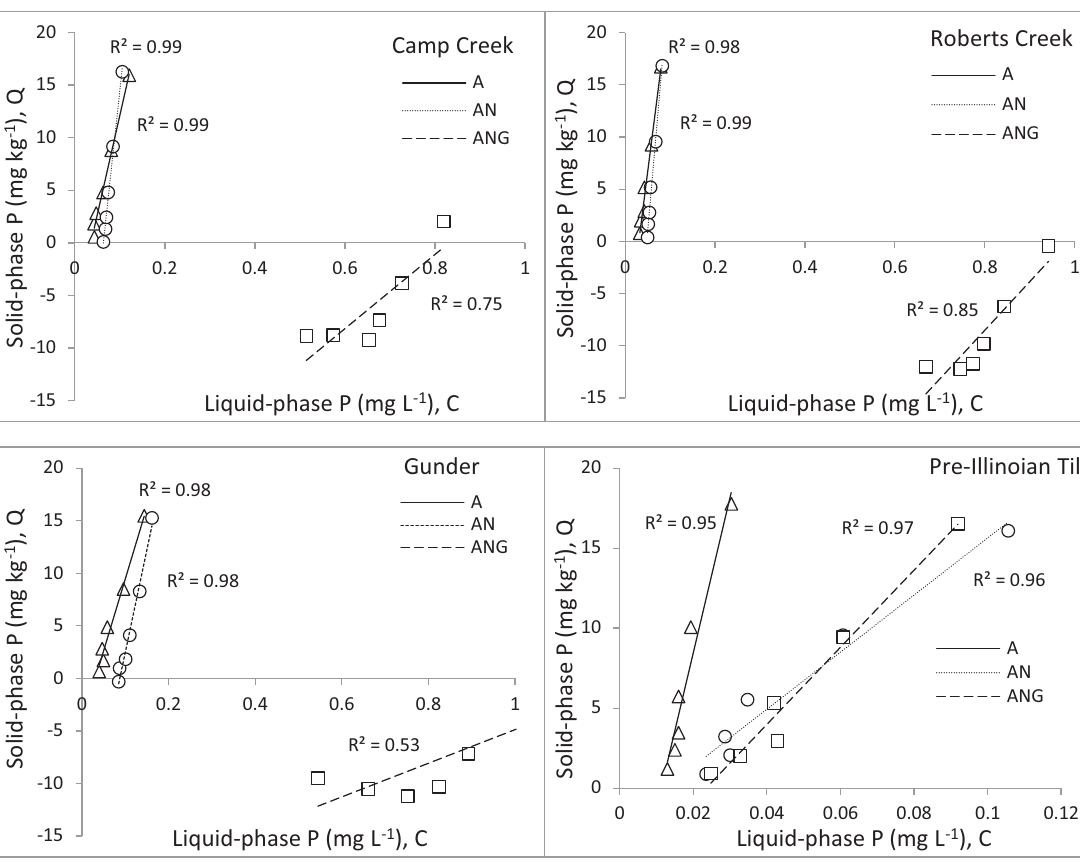
Fig 5. Phosphorus adsorption isotherms developed with simple linear regression for four sediments subjected to three experimental treatments (A = without anaerobic incubation ( Δ ), AN = with anaerobic incubation ( � ), and ANG = with anaerobic incubation + glucose ( □ )). Each of the C and Q values plotted in the graph represents the mean of three